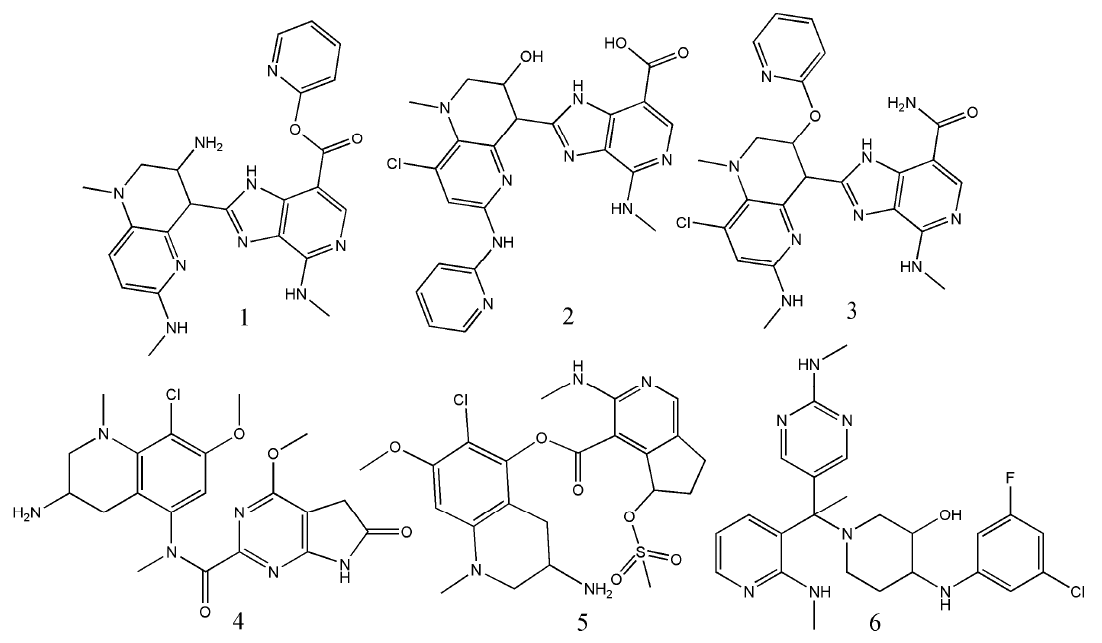
Figure 2. Promising BET bromodomain inhibitory leads proposed in the mtk-QSAR modeling study by Scotti and co-worker [38].